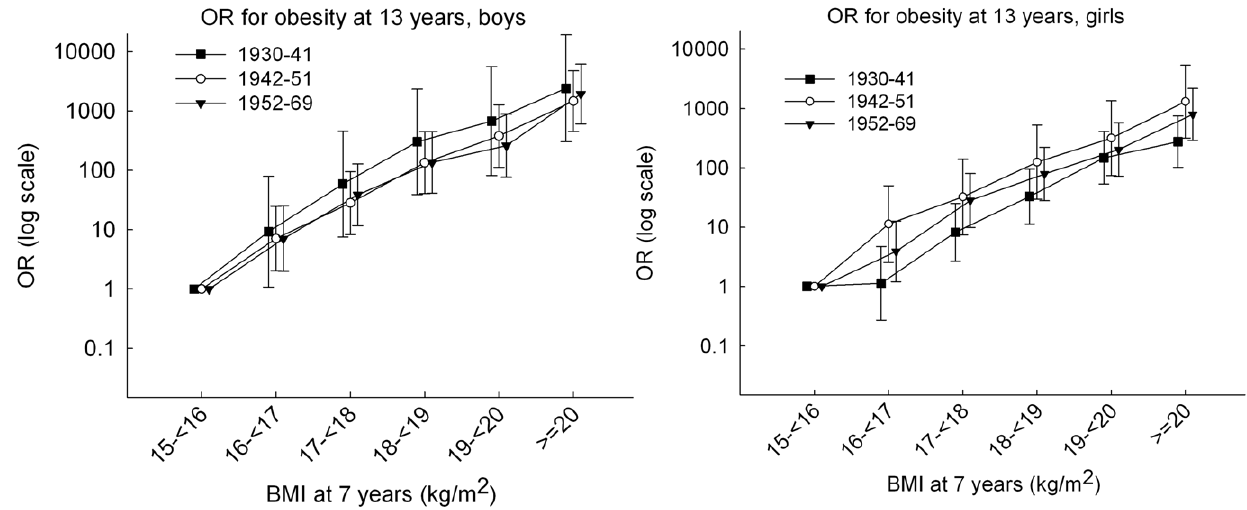
Figure 5. Odds ratio for developing obesity at 13 years by BMI at 7 years and birth cohort. The figure shows the odds ratio with 95% confidence intervals for of obesity at 13 years in relation to BMI at age 7 years and birth cohort (1930–69) among 96 849 boys (left panel) and 96 143 girls (right panel) in the Copenhagen School Health Records Register. Note that the range on the x-axis is truncated at a BMI of 15 kg/m 2 because no boys and only 5 girls with a BMI below 15 kg/m 2 at 7 years became obese at 13 years. Obesity was defined by International Obesity Task Force criteria. BMI, body mass index.